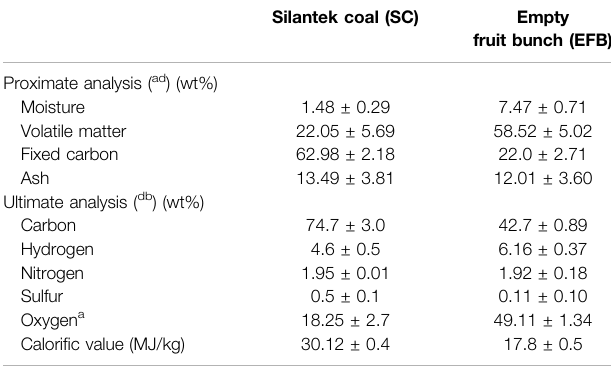
TABLE 1 | Proximate, ultimate, and calori fi c data for EFB and SC. Silantek coal (SC) Empty fruit bunch